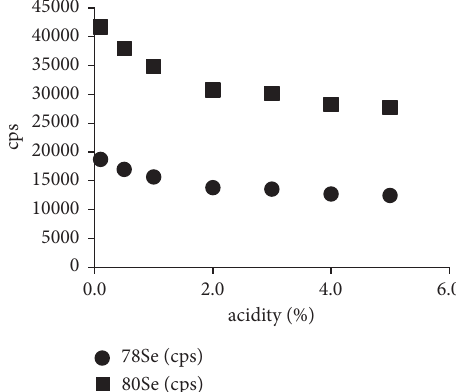
Figure 1: The response signal of 78 Se and 80 Se with